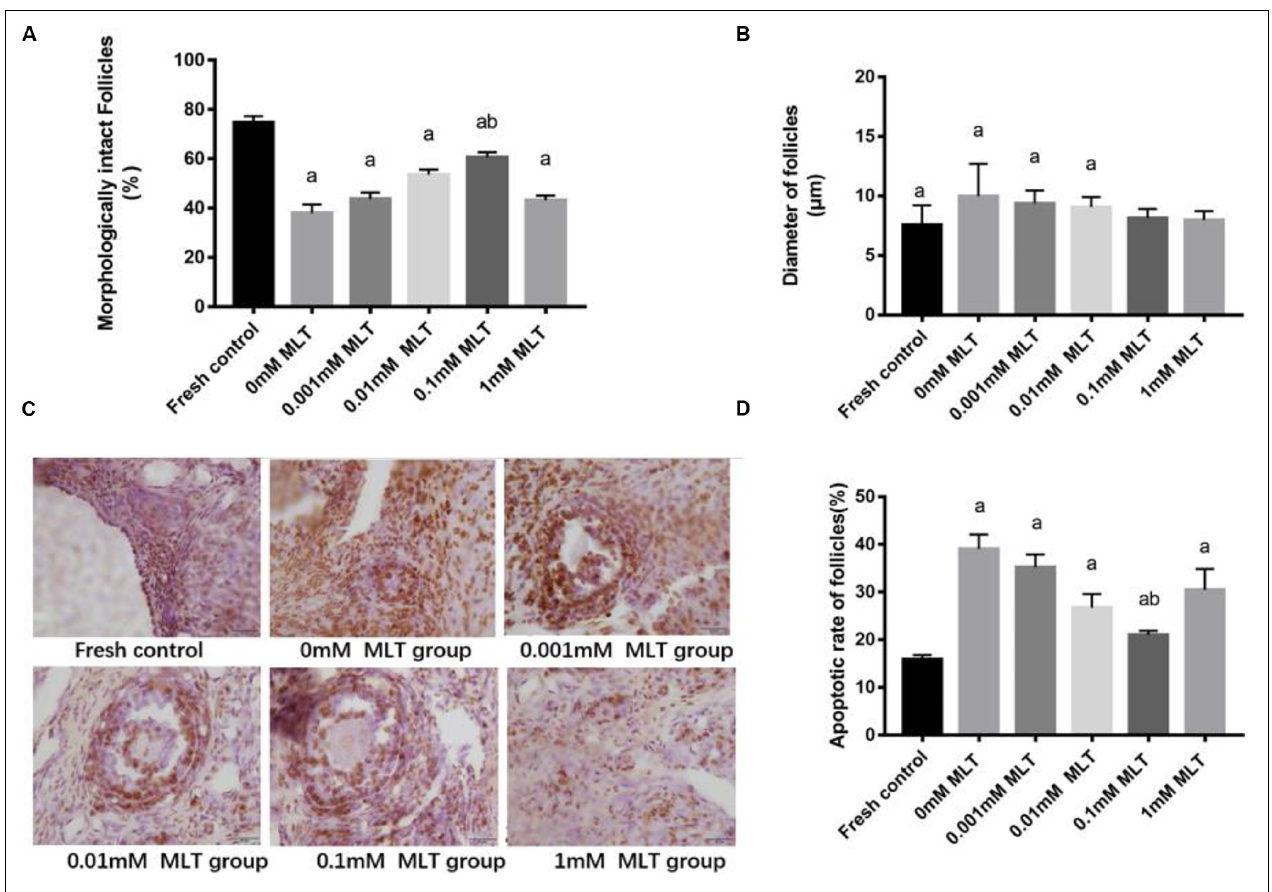
FIGURE 2 | MLT protected the morphological integrity, alleviated the diameter change of follicles, and reduced the apoptotic rate in cryopreserved OTs. (A) Percentage of morphologically intact follicles in fresh control and each MLT-(un)treated group. (B) Diameter of follicles ( µ m) in fresh control and each MLT-(un)treated group. (C) Morphological integrity of follicles in fresh control and each MLT-(un)treated group. (D) Percentage of apoptotic rate in each MLT-(un)treated group. Data are shown as the mean ± SEM. a P < 0.05 compared with the 0-mM MLT-untreated group; b P < 0.05 compared with the MLT-treated